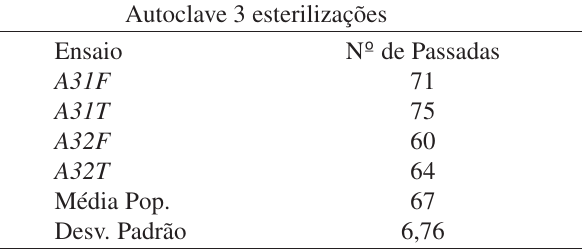
A Fig. 4 apresenta o número médio de passadas